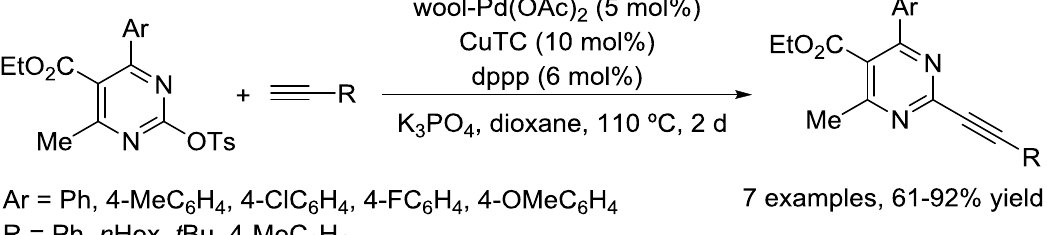
Figure 8. The polysaccharide pectin used for supporting PdNPs and catalyze the Sonogashira cross- coupling